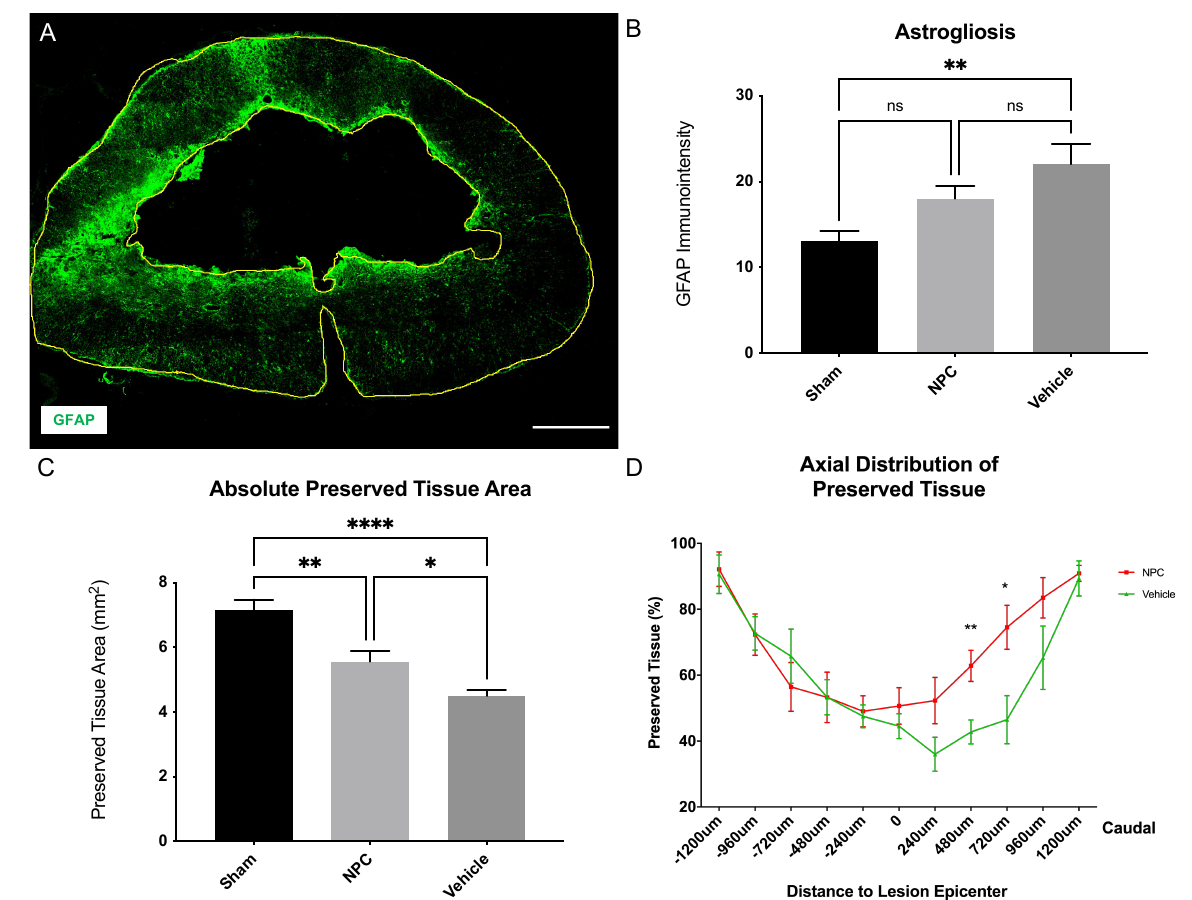
Figure 4. Reactive astrogliosis and tissue preservation in the injured spinal cord eight weeks after severe cervical SCI. ( A ) Spinal cord cross-section of a Vehicle animal stained for GFAP, a marker for reactive astrocytes, at 10 × magnification with the entire spinal cord as well as the intramedullary cystic cavity outlined (yellow lines; scale bar = 500 µ m). ( B ) The immuno-intensity of the GFAP-staining and thus the reactive astrogliosis was comparable in NPC animals (group 1) and Vehicle animals (group 2; n = 8 animals per group; one-way ANOVA with Tukey-HSD-test; p = 0.2624). ( C ) The overall preserved tissue area was significantly higher in NPC animals compared to Vehicle animals ( n = 8 animals per group; one-way ANOVA with Tukey-HSD-test; p = 0.043) ( D ) The percentage of preserved spinal cord tissue along the spinal axis was lowest +/ − 240 µ m from the lesion epicenter in all injured animals, with an increase to 90% towards +/ − 1200 µ m. In comparison to Vehicle animals, NPC animals showed a significant increase of preserved tissue 480 µ m and 720 µ m caudal from the lesion epicenter ( n = 8 animals per group; one-way ANOVA with Tukey-HSD-test; p = 0.0071 and p = 0.0177, respectively) (* p < 0.05; ** p < 0.01; **** p < 0.0001 and ns = not